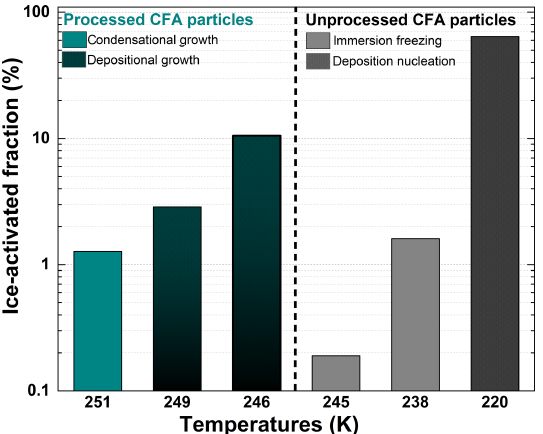
Figure 6. Freezing experiment data for unprocessed and processed CFA_Cy particles at 251 and 253K start temperatures ( T start ) . These data correspond to experiments 5 and 15 in Table 2, re- spectively. The individual panels contain the same data types as in Fig. 3. The short-dashed blue lines indicate the beginning of the cloud droplet